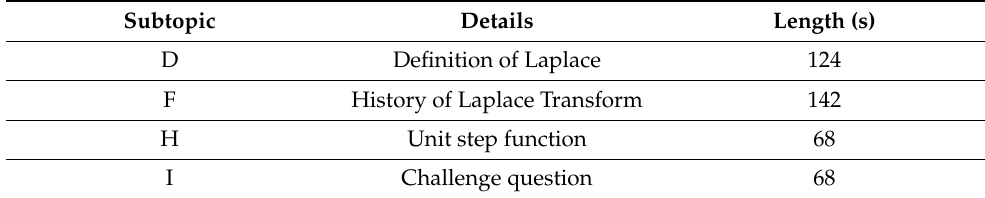
Table 1. Subtopics of the delivered Laplace Transform lecture.